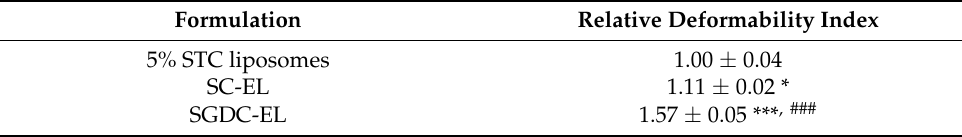
Table 2. Relative deformability index of the elastic liposomes (SC-EL and SGDC-EL). Data are expressed as mean ± SD ( n = 3). * p < 0.05 vs. 5% STC liposomes, *** p < 0.001 vs. 5% STC liposomes, and ### p < 0.001 vs.